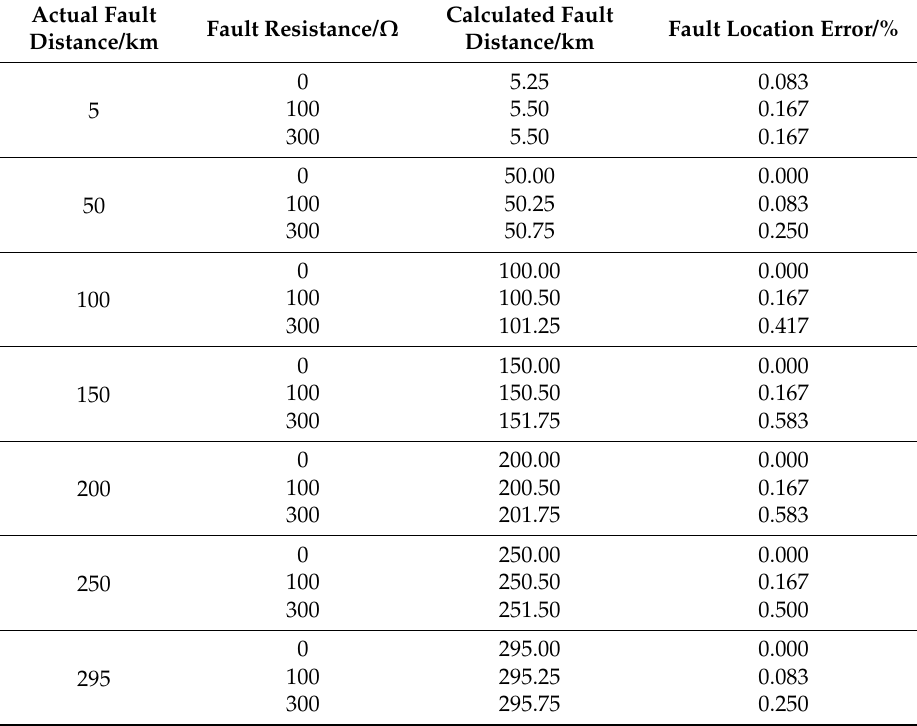
Table 3. Partial results of the location error with different resistances and different